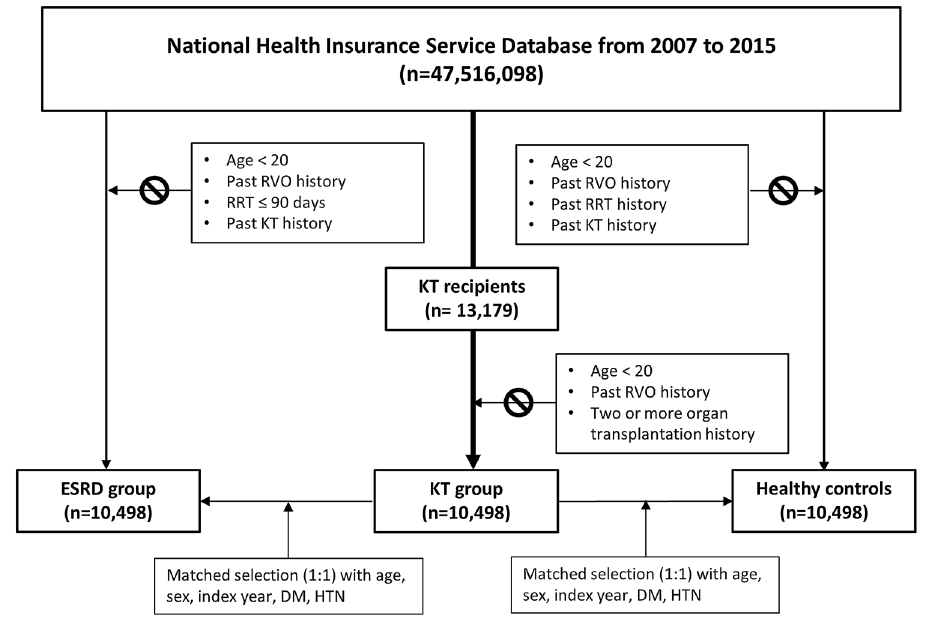
Figure 2. Flowchart depicting the identification of the KT group, the ESRD group, and the healthy controls. ESRD end-stage renal disease, DM diabetes mellitus, HTN hypertension, KT kidney transplantation, RRT renal replacement therapy, RVO renal vein